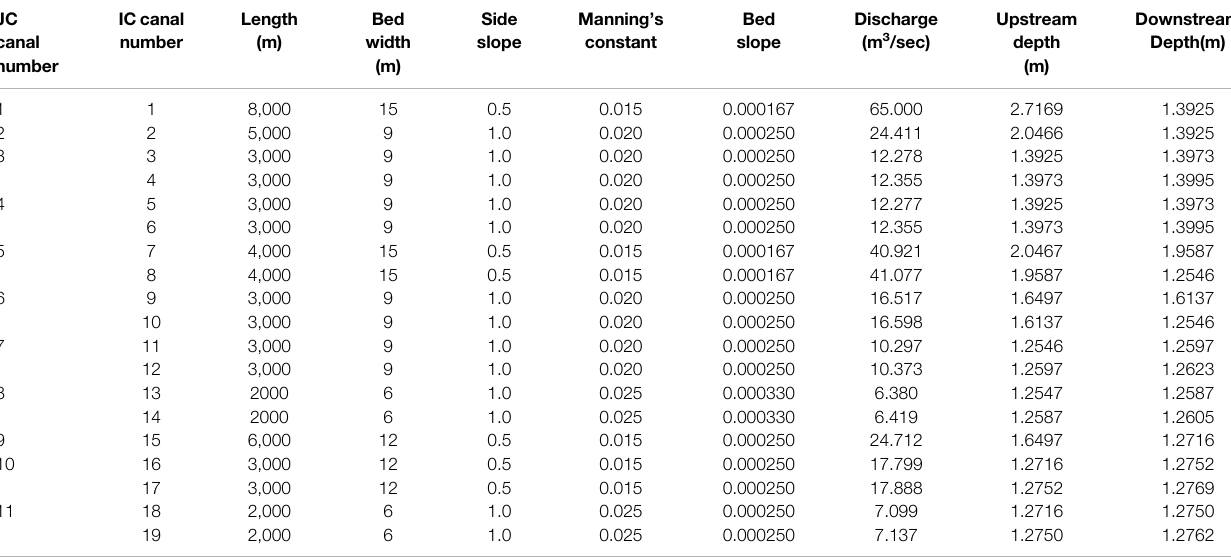
TABLE 1 | Channel characteristics and solution for illustrative example network in Figure 2